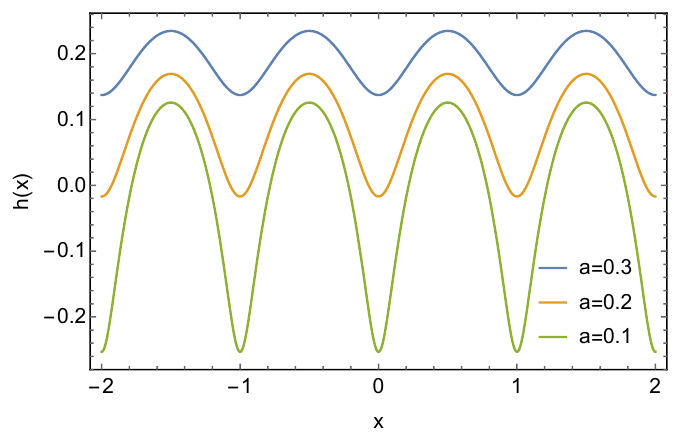
Figure 4: Nonlinear surface wave profiles h ( x ) given by Eq. 70 for k = 2 π and a = 0.1,0.2,0.3 from bottom to top.